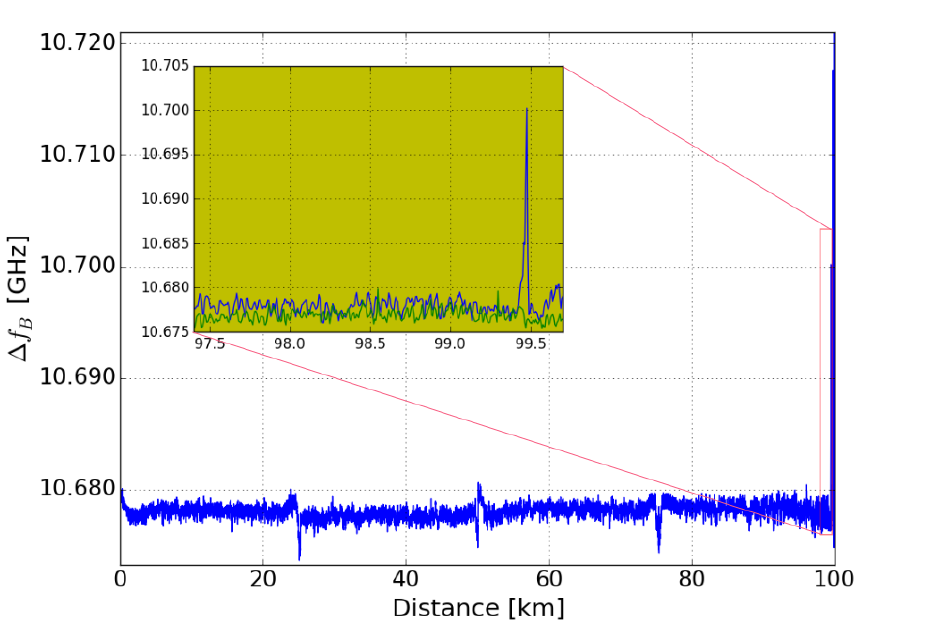
Figure 3. BFS over distance of 100-km sensing fiber, with 30 ◦ C hotspot (blue), reference